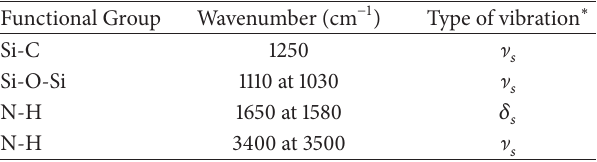
Table 1: Bands assigned in the FTIR spectrum for SGAPC. Functional